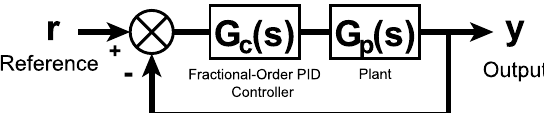
Figure 4. Closed-loop control diagram considered to regulate the voltage of the DC–DC Buck converter of the Figure